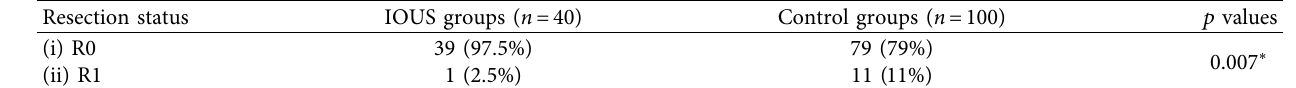
Table 5: Resection margin according to the fnal histopathological